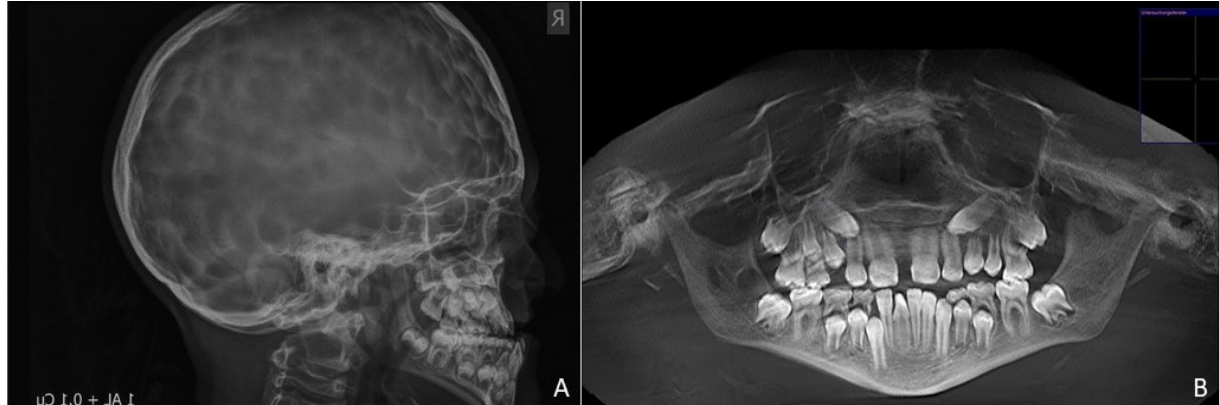
Figure 2. Pretreatment radiographs. ( A ). Lateral cephalogram showing extreme mesial–basal jaw relationship. Prominence of convolutional markings throughout the neurocranium indicates chronic increase in intracranial pressure. ( B ). Panoramic view of a digital volume tomogram showing impaction of maxillary canines and short skeletal base of micrognathic maxilla.